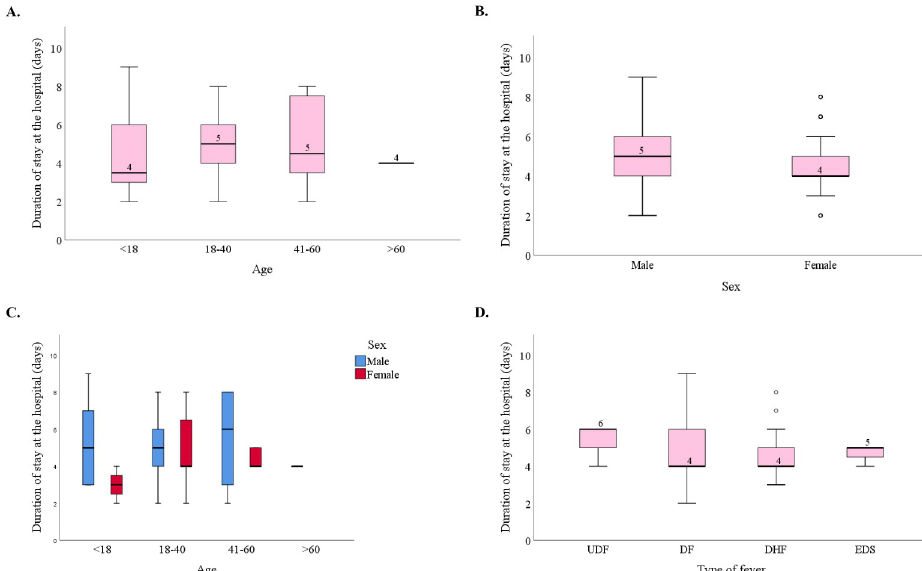
Fig 7. Duration of stay at the hospital (days) and its relationship with demographic factors and with the type of dengue fever observed in the patient. (A) Box plot showing the relation of age and duration of stay at the hospital. (B) Box plot showing the relation of gender and duration of stay at the hospital. (C) A clustered box plot showing interrelation among age, sex and duration of stay in the hospital. (D) Box plot showing the relation of type of dengue fever and duration of stay at the hospital. Circles (o) above the DHF box indicate outlier cases with extreme duration of stay at the hospital.